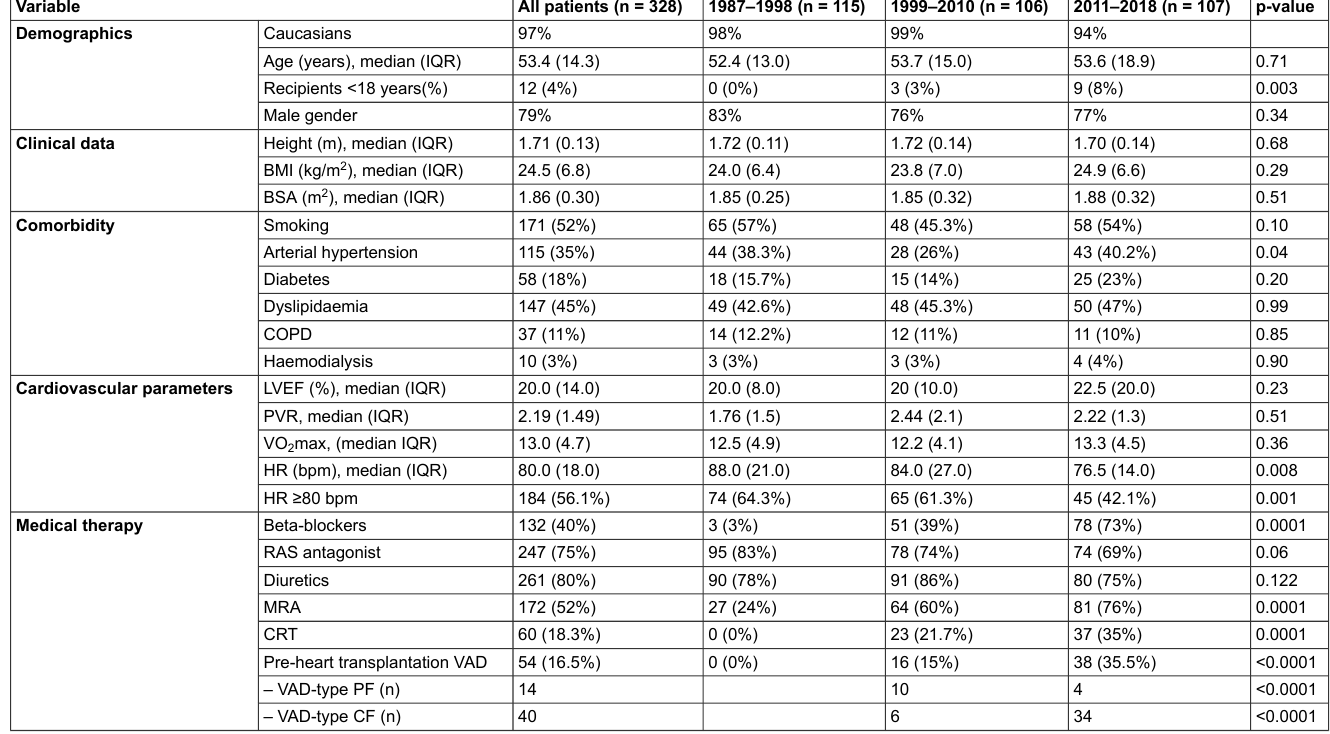
Table 1: Demographic and clinical parameters.